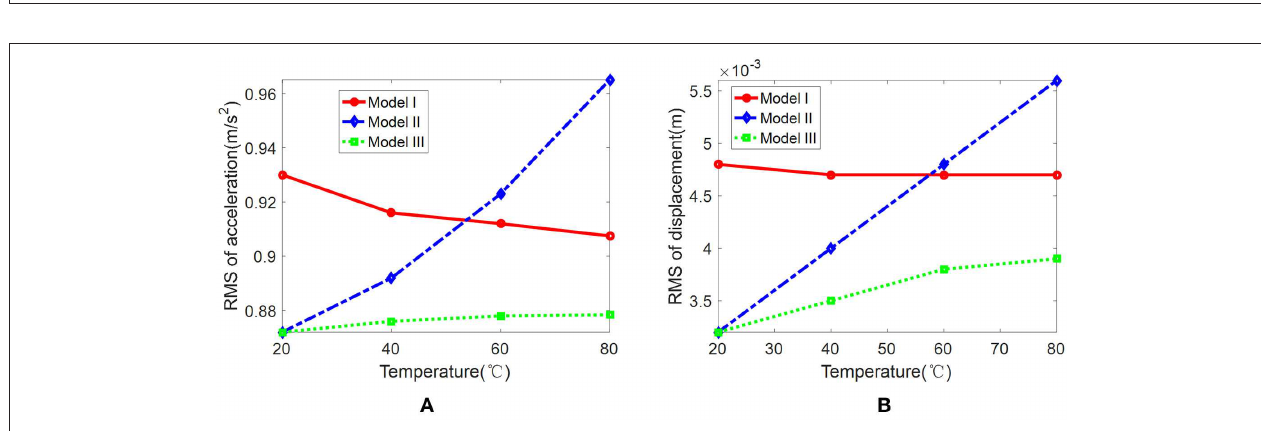
FIGURE 14 | Control performances of semi-active system with different models under different temperatures. (A) RMS of acceleration response. (B) RMS of displacement response.